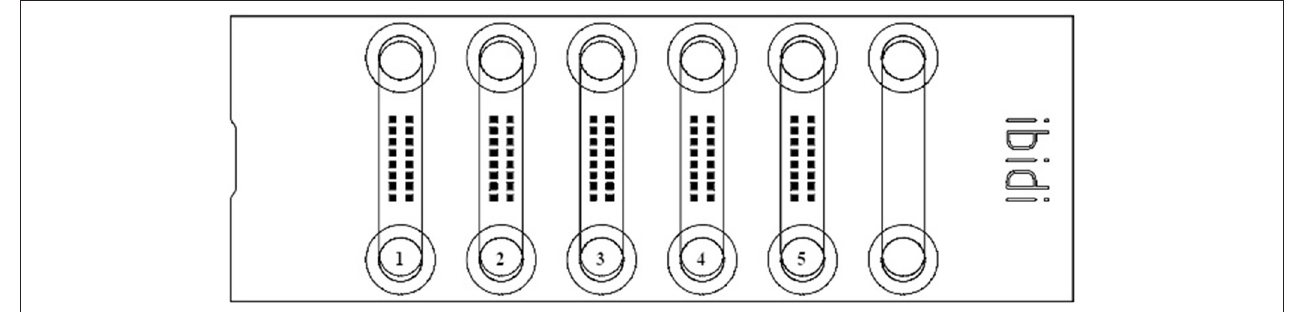
FIGURE 2 | Schemata of an ibidi ® µ -Slide VI 0.4 flow chamber with the rectangular grid of 16 defined areas [filled square ( (cid:4) ); 184.5 × 184.5 µ m], where images were captured for further analysis of lipid droplets. The different treatments for each µ -slide are shown: (1) 100 µ M oleic acid; (2) base medium; (3) 50 µ M stearic acid; (4) control; and (5) 60 µ M palmitic